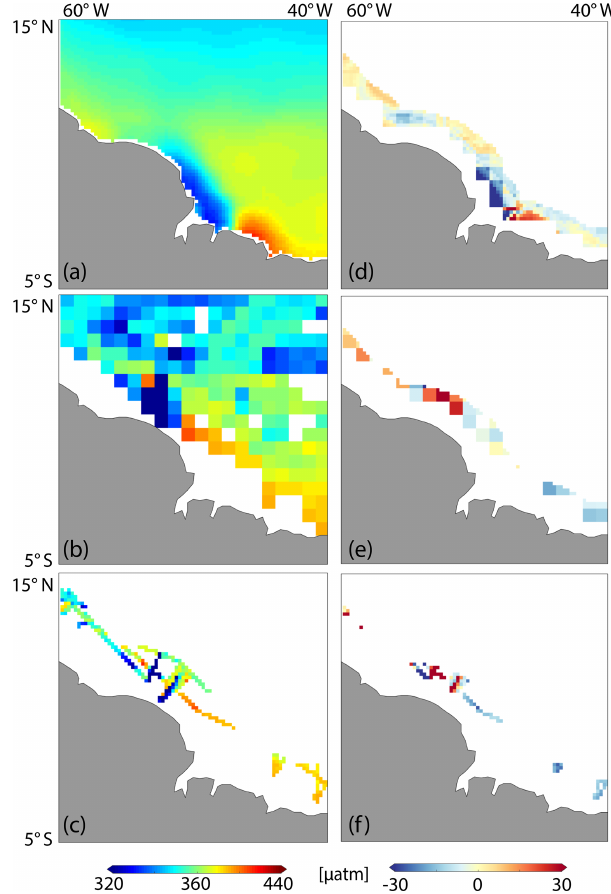
Figure 13. Mismatch analysis along the Amazon outflow region for the 1998 through 2015 period. The climatological mean p CO 2 is reported for (a) the merged product, (b) all available SOCATv5 data for the open ocean, and (c) all coastal SOCATv5 data (as illustrated in Fig. 1 for the global ocean). The p CO 2 mismatch is illustrated in (d) as the difference between NN coast and NN open . Panel (e) reports the mismatch between the NN open and the SOCATv5 open-ocean dataset along the overlap area, while panel (f) reports the mismatch between the coastal product and the SOCATv5 coastal dataset along the overlap